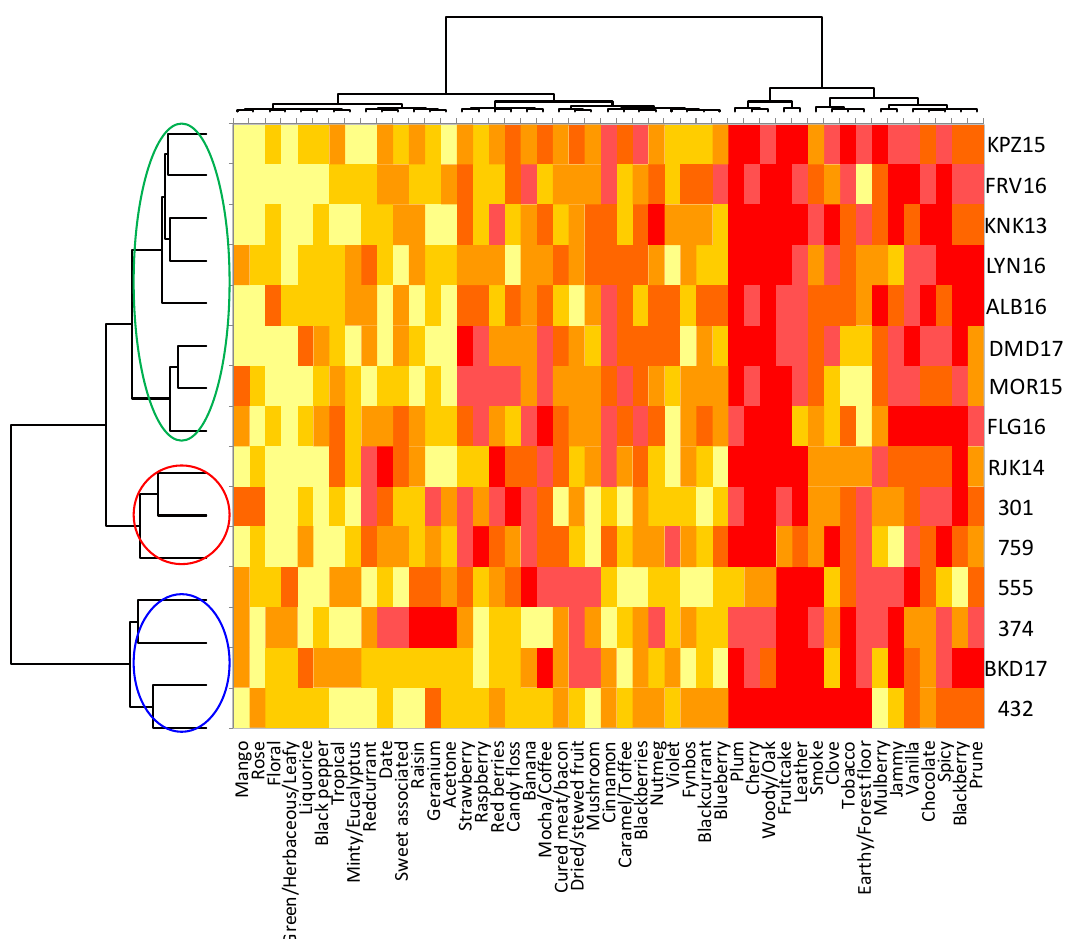
Figure 3. Heatmap associated with the results of the check-all-that-apply (CATA) task for the Pinotage wines evaluated. The dendrogram on the left corresponds to the Hierarchical Cluster Analysis (HCA) on the CATA results. Wine codes as indicated in the text.